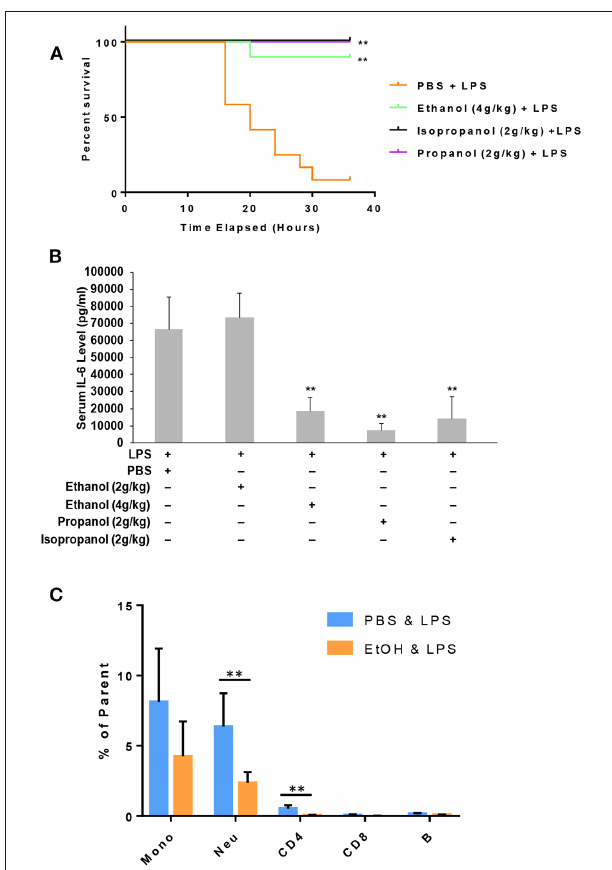
FIGURE 5 | Short-chain alcohol protection against LPS septic shock. (A) Survival curves. C57BL/6 mice were i.p. injected with ethanol (4 g/kg), isopropanol (2 g/kg), propanol (2 g/kg), or PBS. One hour later, the animals were challenged with a lethal dose of LPS (10 mg/kg). The animals were observed for 36h. The Kaplan-Meier survival curve for each group of animals was traced, and statistical comparisons were performed by Log-rank test. Asterisks denote significant difference in each comparison with PBS group or indicated group ( n = 10 per group, p < 0.01). (B) Short-chain alcohols attenuate host inflammatory response to LPS. C57BL/6 mice were i.p. injected with ethanol (2 g/kg or 4 g/kg), isopropanol (2 g/kg), propanol (2 g/kg), or PBS. One hour later, the animals were challenged with LPS (10 mg/kg). Sixteen hours after LPS challenge, the animals were bled. Serum from each animal was obtained and measured for IL-6 levels. Asterisks denote significant difference in each comparison ( n = 4 per group, p < 0.01). (C) Ethanol exposure significantly affects cellular Phospho-I κ B levels in monocytes and neutrophils. Peripheral blood WBCs were isolated from the mice that had been exposed to 4 g/kg ethanol and LPS (10 mg/kg) or the control mice that had been exposed to PBS and LPS (10 mg/kg). Immunostainings for cell surface markers (CD11b, Ly6G, CD19, CD3, CD4, and CD8) and phospho-I κ B were performed. Monocytes (CD11b + Ly6G − ), neutrophils (CD11b + Ly6G + ), B lymphocytes (CD19 + ), CD4 lymphocytes (CD3 + CD4 + ), and CD8 lymphocytes (CD3 + CD8 + ) were categorized. Percentage of the phospho-I κ B-positive cells in each cell type of the gated population were compared between the ethanol and control groups. Asterisks denote statistically significant difference by student’s t -test ( p < 0.01, n ≥ 3 per